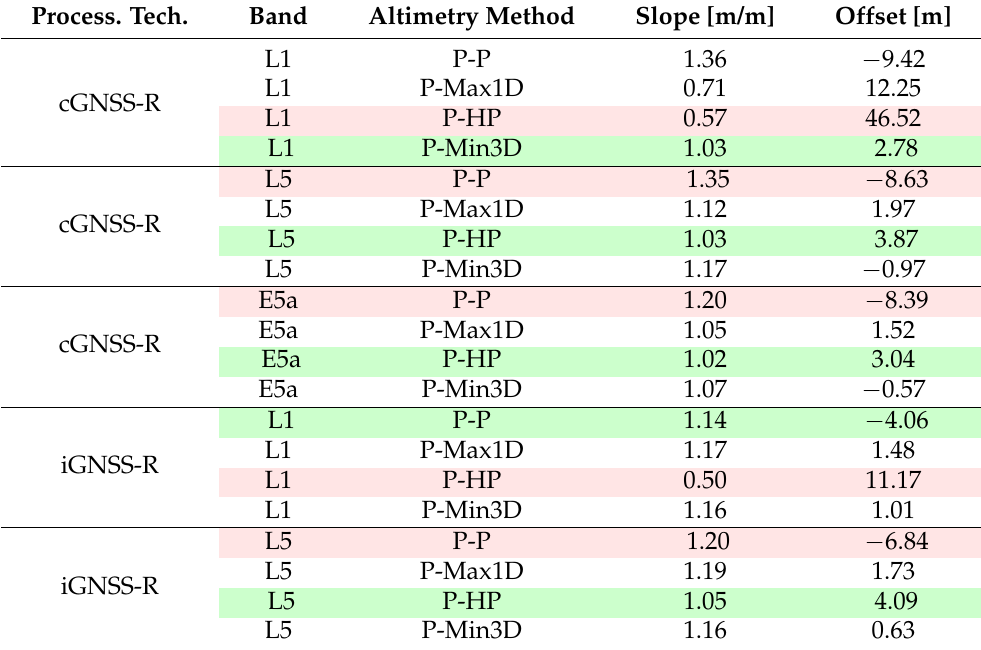
Table 2. Slopes and offsets of the regressions for the different GNSS-R altimetry methods, bands, and processing techniques with respect to the CryoSat-2 data. Using T coh = 1 ms and T incoh = 100 ms. Process.